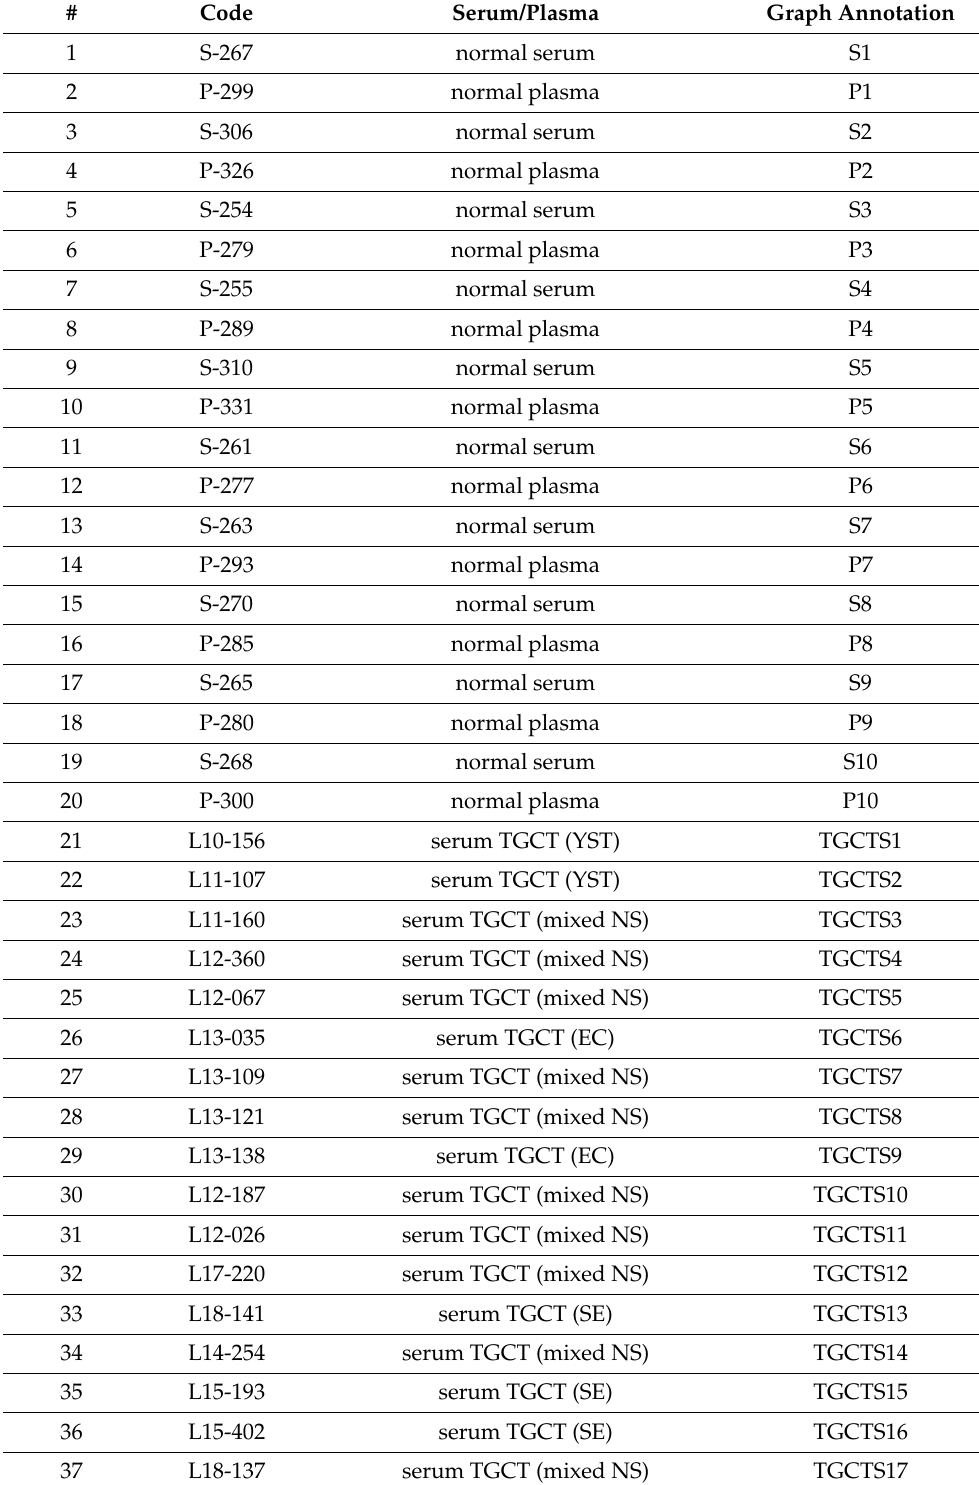
Table 1. Sample codes. Corresponding samples linked to codes used in